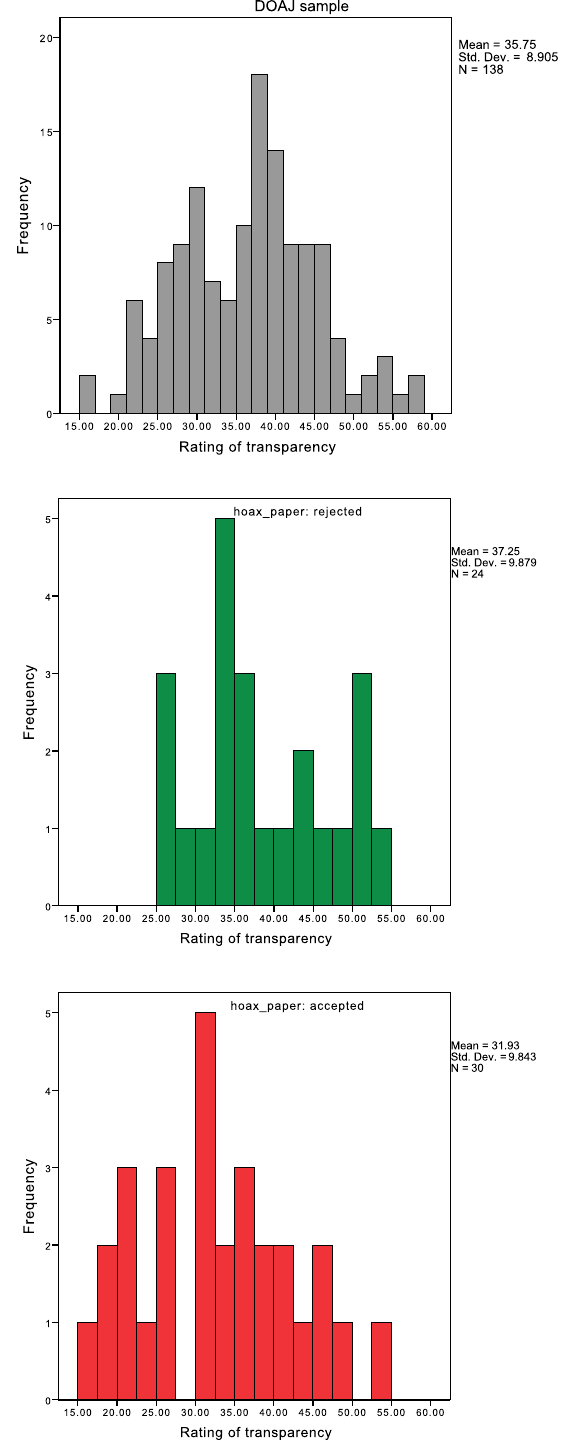
Fig 1. Distributions of transparency scores (sum of all items) in the DOAJ sample (top), and for journals that accepted (middle) or rejected (below) Bohannon ’ s hoax article.